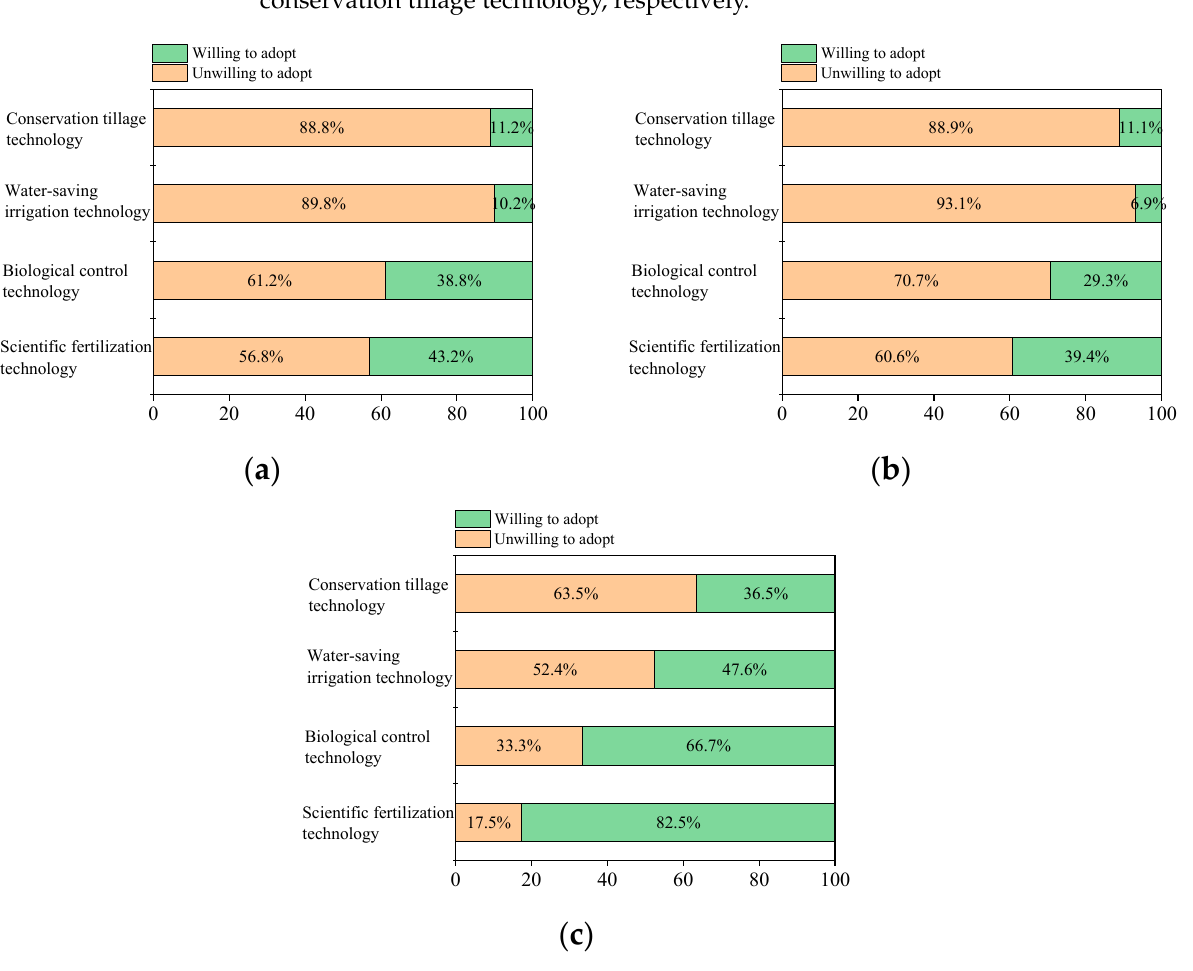
Figure 2. The smallholders’ demand for different green production technologies in wheat, maize, and rice. ( a ) wheat ( n = 410), ( b ) maize ( n = 566), ( c ) rice ( n = 126).